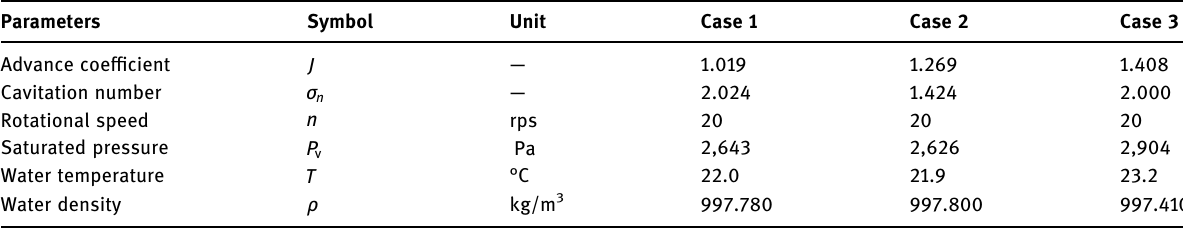
Table 2: Operational parameters Parameters